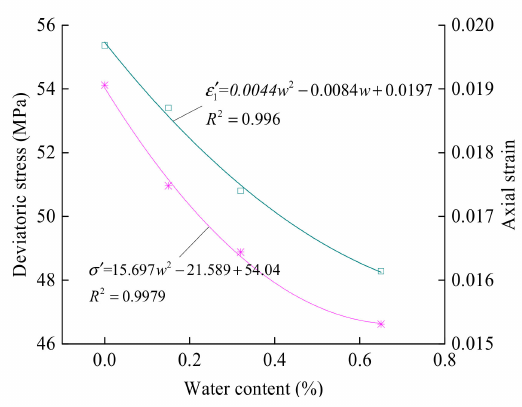
Figure 5. The peak strength, peak axial strain of the sample with water content